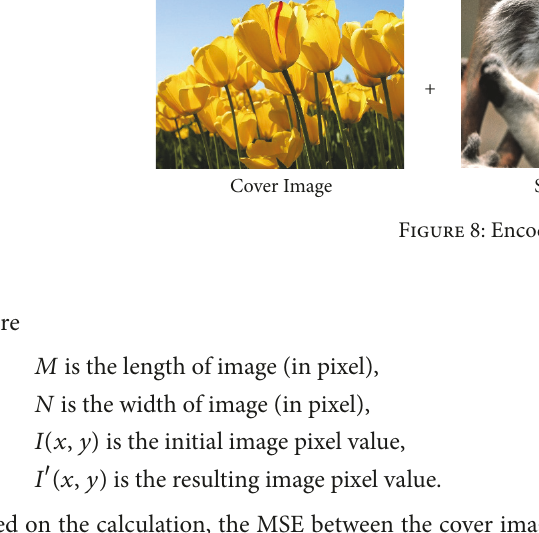
coding method, we use koala image (1024 × 768) as a secure image and tulips image (1024 × 768) as cover